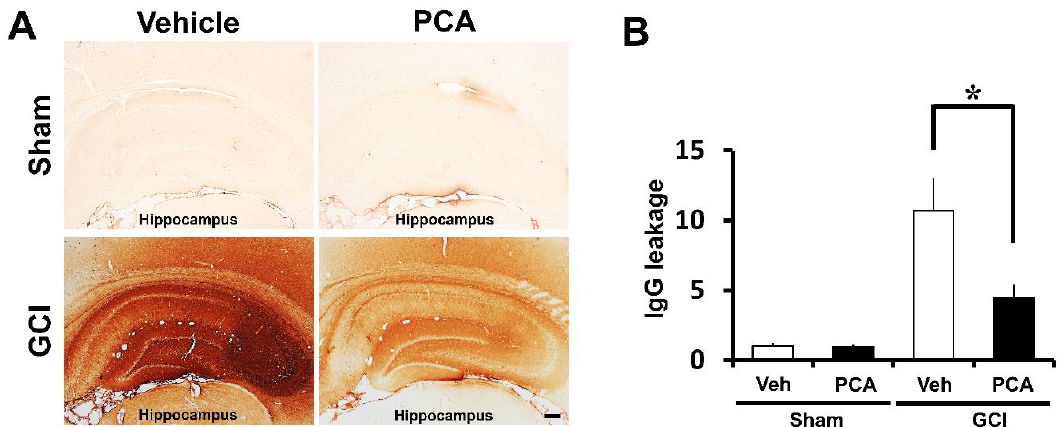
immunoglobulin through the blood – brain barrier (BBB) disruption in the hippocampus after